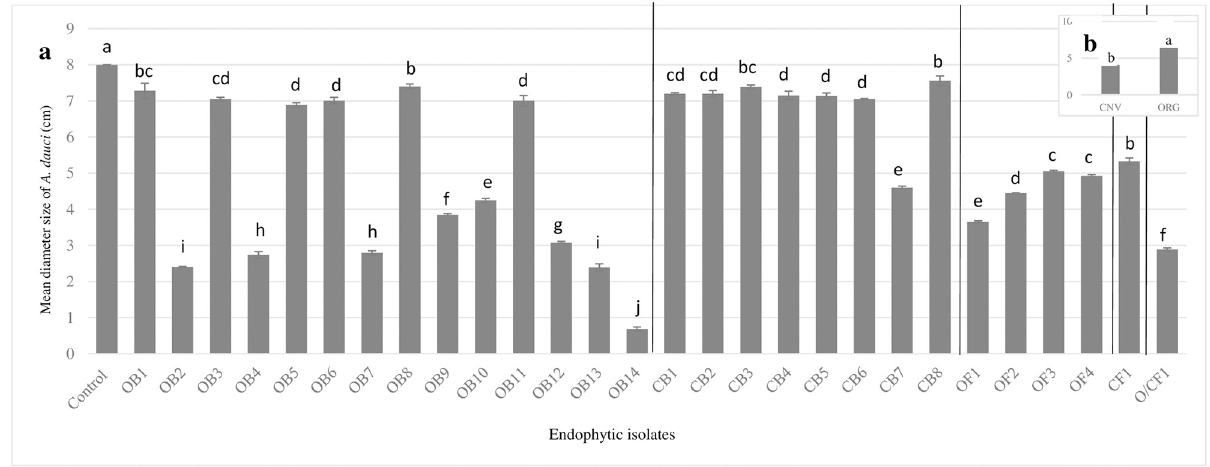
Fig 3. Antagonistic activity of individual endophytic microbes isolated from the taproots of nine diverse carrot genotypes grown in soil managed using organic and conventional farming practices (a) and endophytic isolates averaged across management system (b) against Alternaria dauci using an in vitro bioassay. Letters indicate significant differences between the endophytic isolates and management system ( P < 0.001).